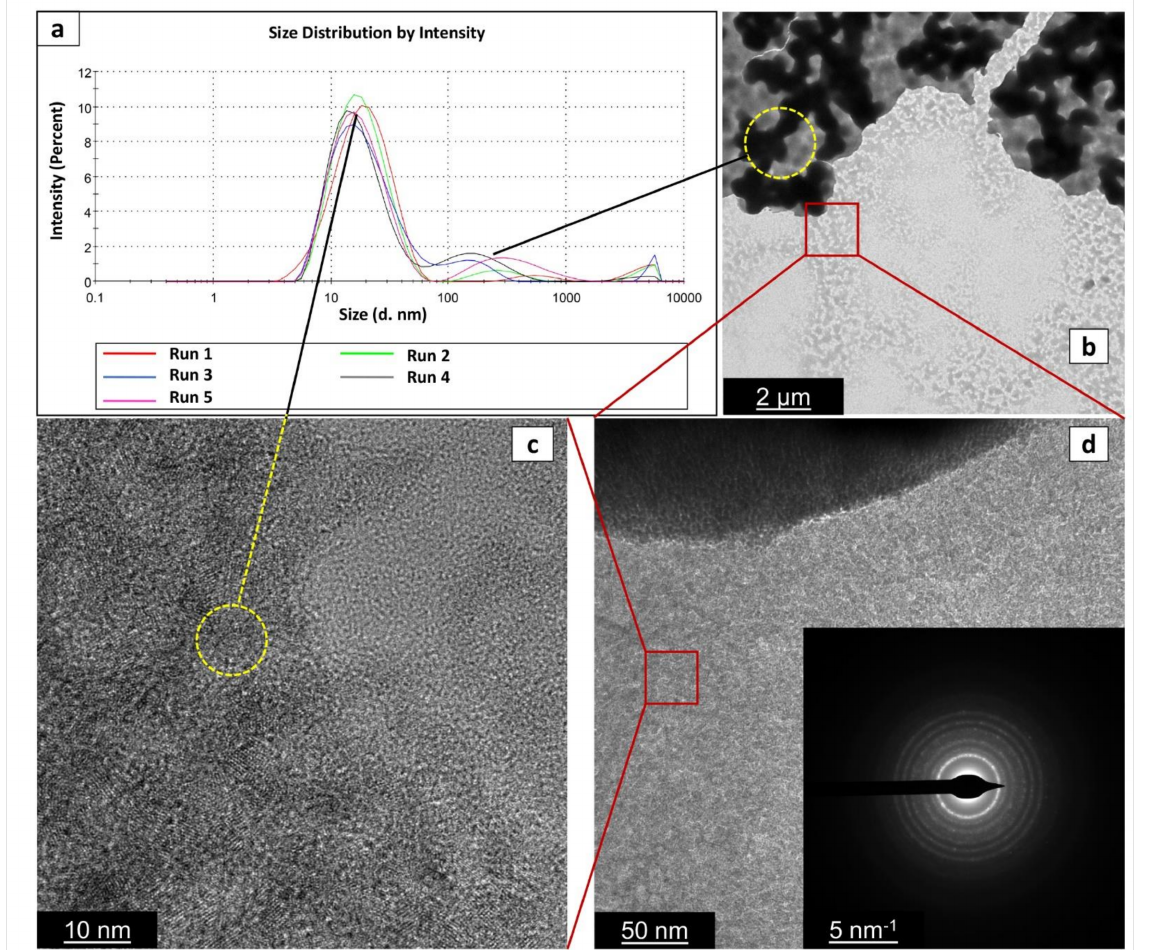
Figure 5. Particle size distribution via DLS analysis ( a ), TEM ( b ), and HRTEM ( c , d ) images of the sample TiO 2 _60_Powd. With black lines and yellow circles, we indicate that images in ( b , c ) can provide a visual representation of the two peaks observed in ( a – c ), and ( d ) images were taken in the same area of the sample progressively magnified (indicated by red squares). Inset in ( d ) gives the selected area electron diffraction (SAED) image of the red squared area in ( d ).